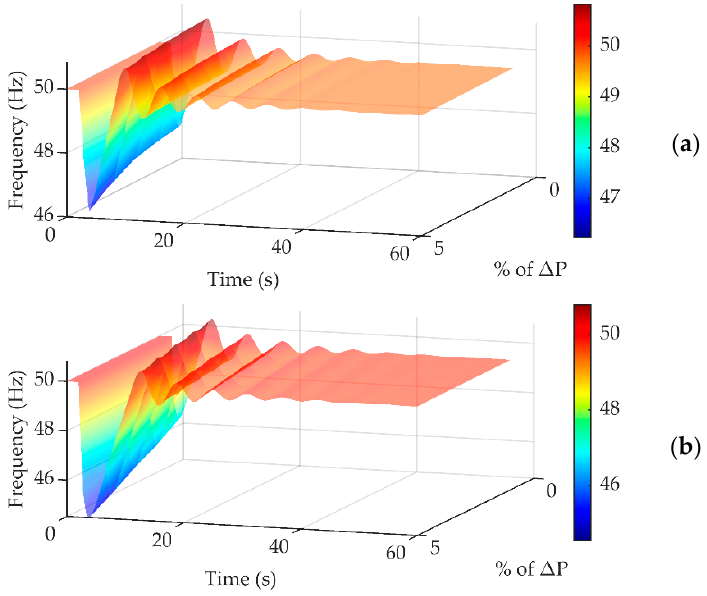
Figure 12. Frequency response by decreasing ∆ P from 1% to 5%: ( a ) high inertia—summer season; ( b ) low inertia—winter season.